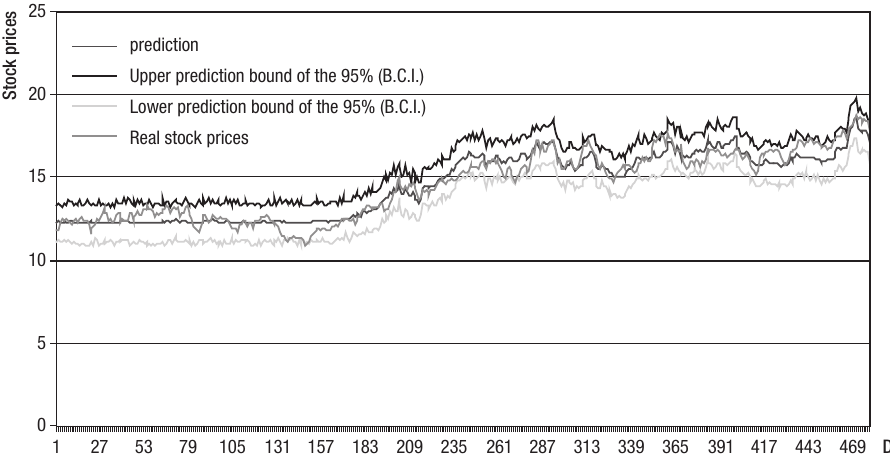
Fig. 3. The observed and the predicted prices of Alpha Bank stock, the Upper Confi dence Limit (UCL) and the Lower Confi dence Limit (LCL) of the (1- α )*100% (C.I) of the predicted pricesTable 1 presents the forecasted prices, the Upper Confi dence Limit (UCL) and the Lower Confi dence Limit (LCL) of the (1- α )*100% (C.I) of the forecasted prices for the last 20 observations of the